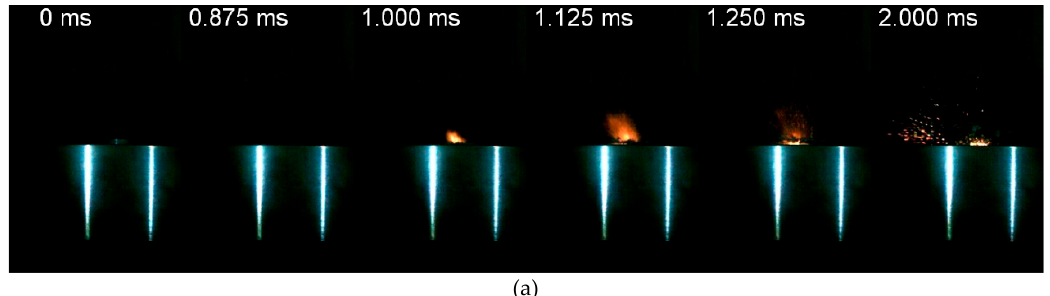
Figure 9. Impact response of HTSed type C and type E reactive material under the same drop height: ( a ) type C; ( b ) type E.